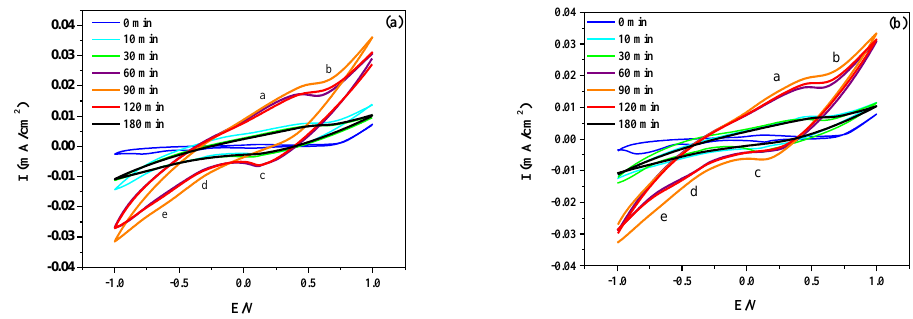
Figure 4. The forward cyclic voltammetry (CV) ( a ) and reverse CV ( b ) of chalcopyrite. Table 1. Contact angle under different ball grinding time.